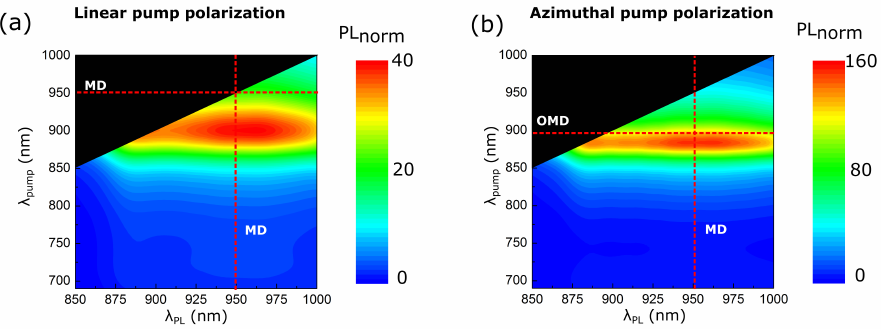
Figure 4. Numerical results of QDs µ -PL for various pump polarizations. Numerically obtained PL enhancement for linear ( a ) and azimuthal ( b ) polarizations of the pump radiation for GaAs nanopillars coupled with InAs QDs on the GaAs substrate. MD is the magnetic dipole Mie-type mode, OMD—collective out-of-plane magnetic dipole